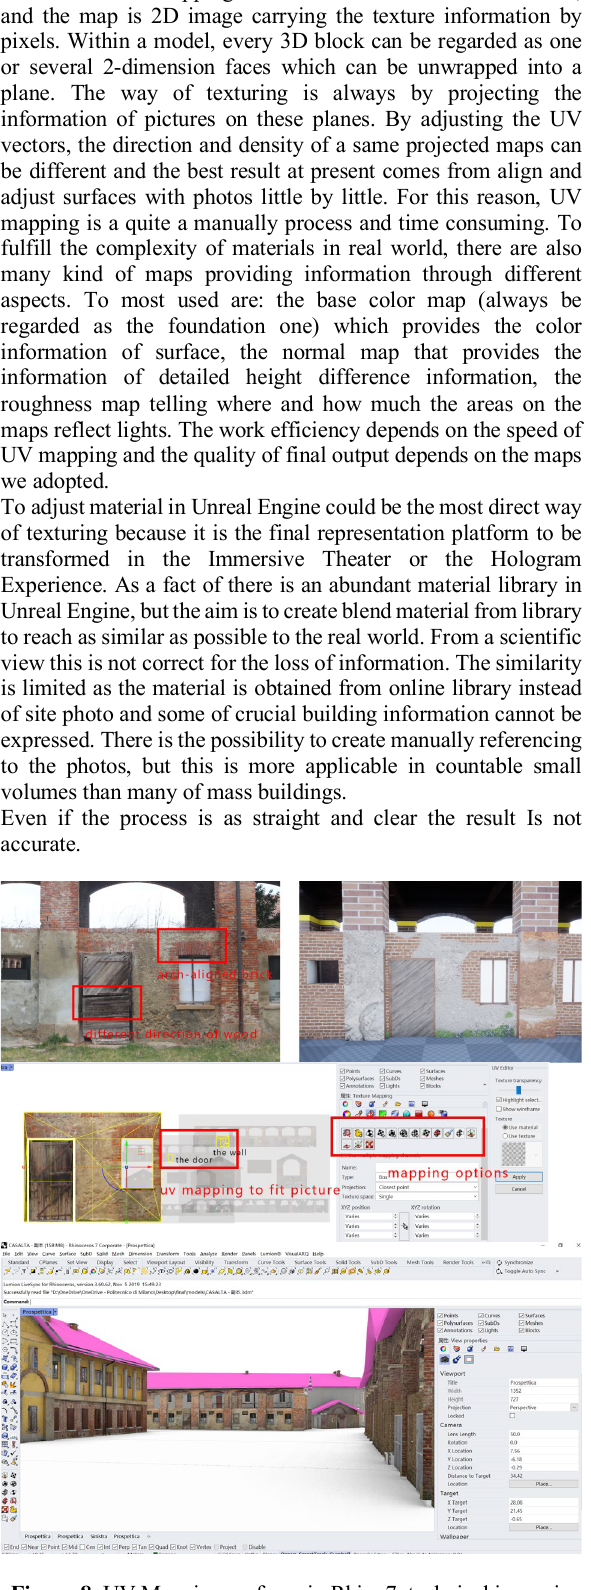
Figure 8 . UV Mapping surfaces in Rhino7, technical issues in small or larger